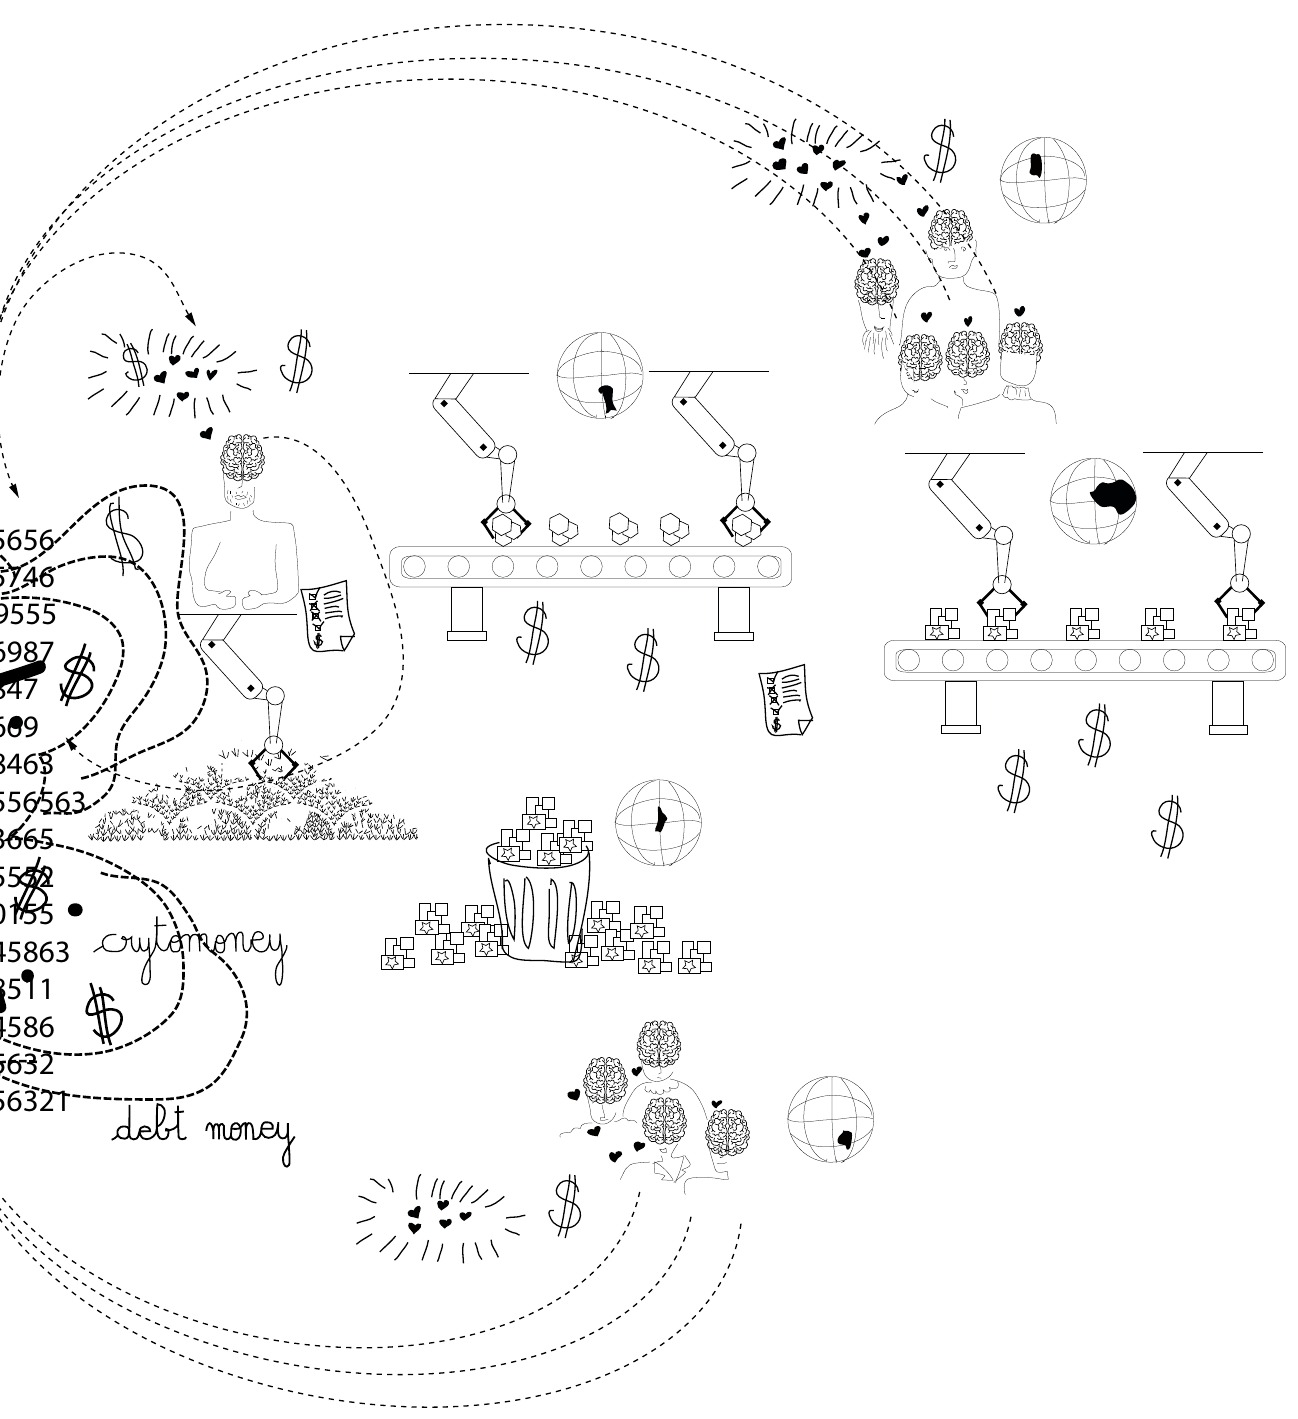
Figure 3: Hyper-normalisation. Source: Nathalie